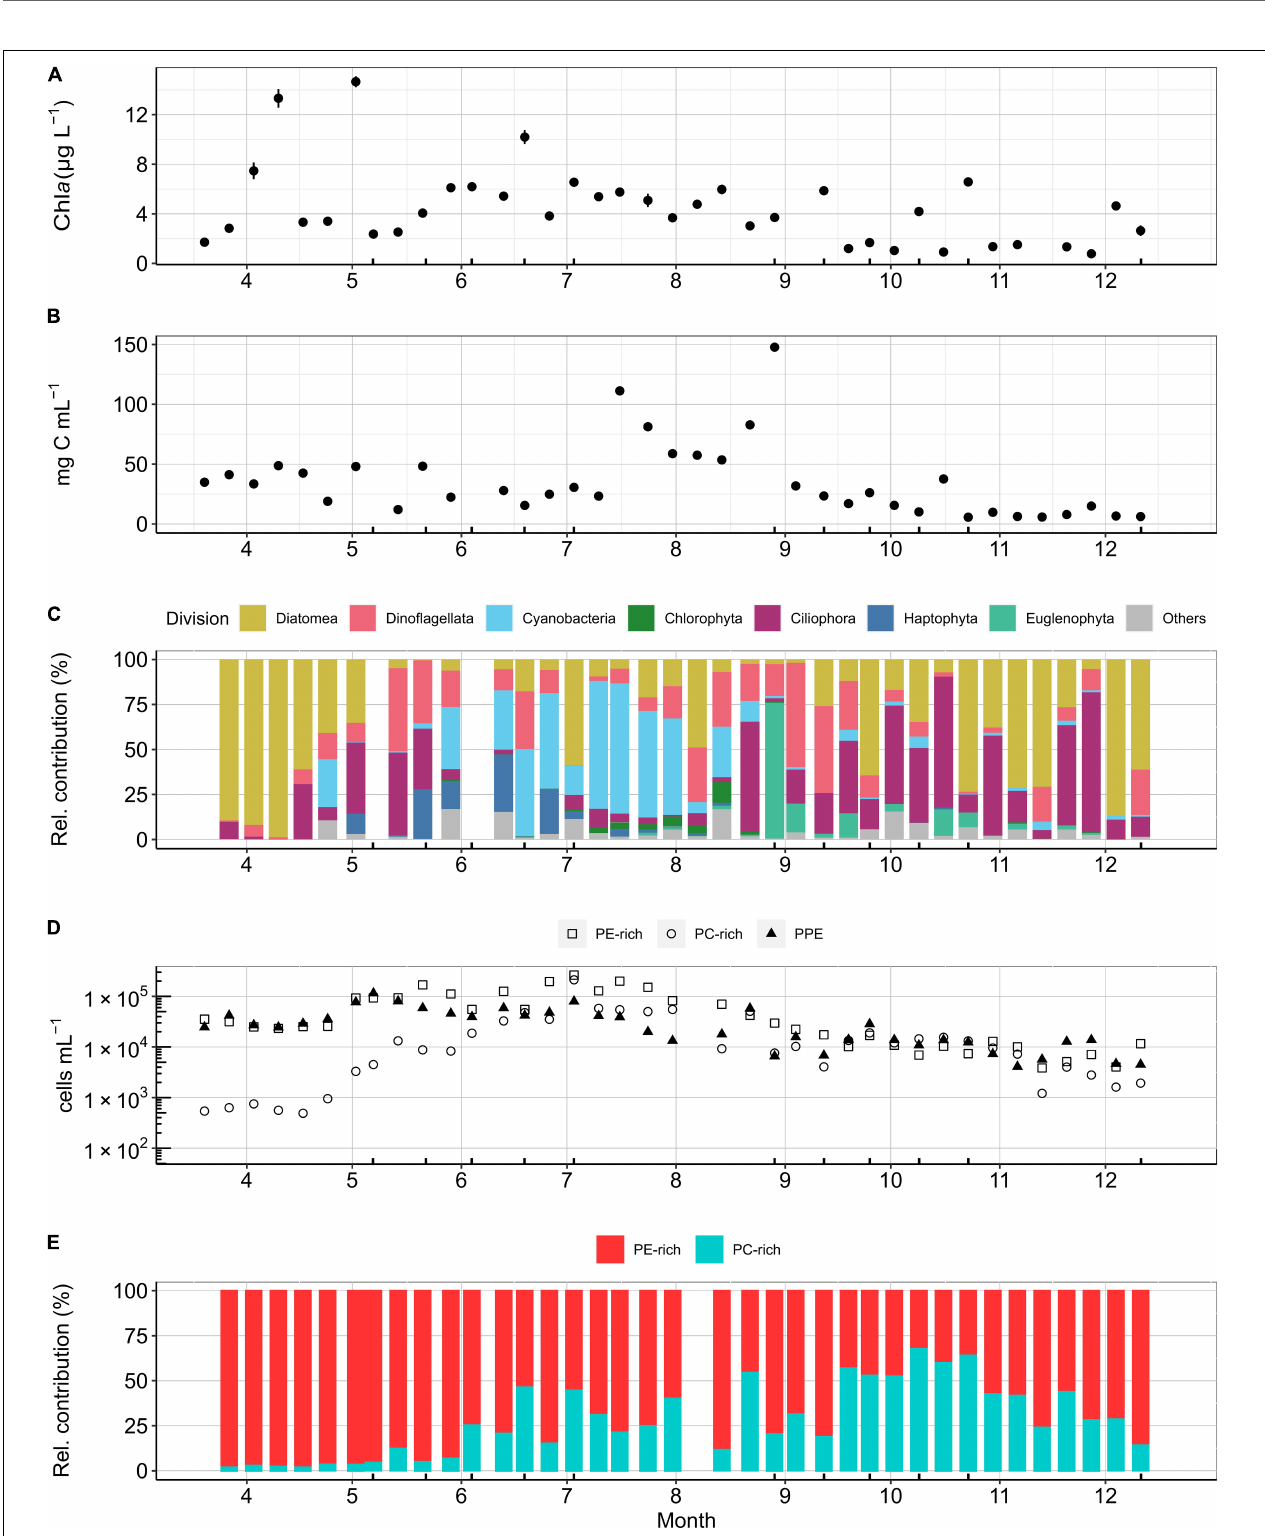
FIGURE 2 | K-station weekly measurements for (A) Chl a ( µ g L - 1 ), (B) total phytoplankton ( > 5 µ m in diameter) carbon biomass concentration (mg C m - 3 ) based on microscopy, (C) relative contribution of phytoplankton divisions ( > 5 µ m in diameter) to total biomass (mg C m - 3 ) calculated from microscopic counts microscopy, (D) PE-rich, PC-rich, and PPE cell concentration in a logarithmic scale (cells mL - 1 ), and (E) relative contribution of PE-rich and PC-rich (%) based on flow cytometry cell counts. Ticks on the x -axis mark the dates when a bioassay was performed.